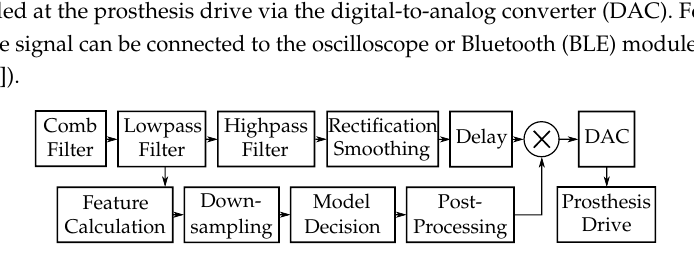
Figure 2. Signal flow of the digital signal processing. The decision of the model (0 for artifacts or 1 for contractions) is multiplied with the delayed processed EMG